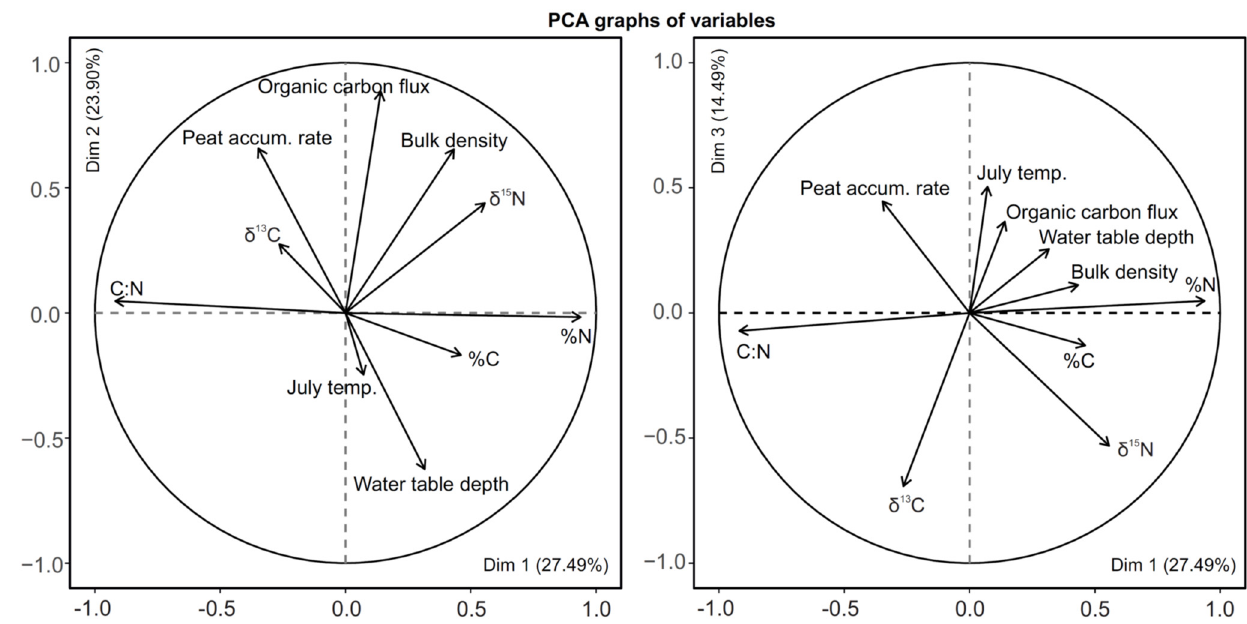
Figure 10. PCA of Teringi Bog core data and regional paleoclimate records of water table fluctuations [45] and July temperatures recorded in the Baltic region [44].